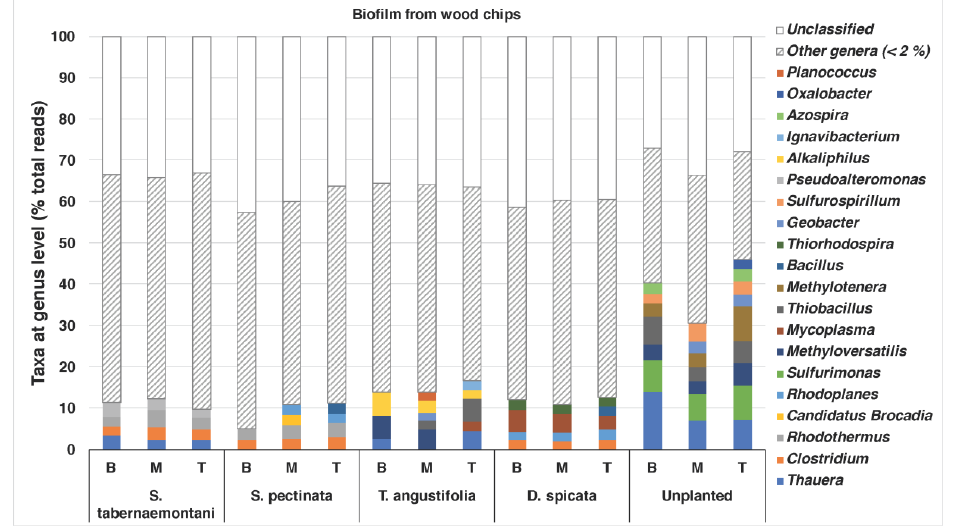
Figure 5. Relative bacterial composition at the genus level in the biofilm wood-chip samples. ”Other genera” is the sum ratios of genera with less than 2% abundance. B, M and T represent the bottom (60 cm), middle (40 cm) and top (20 cm) depths,